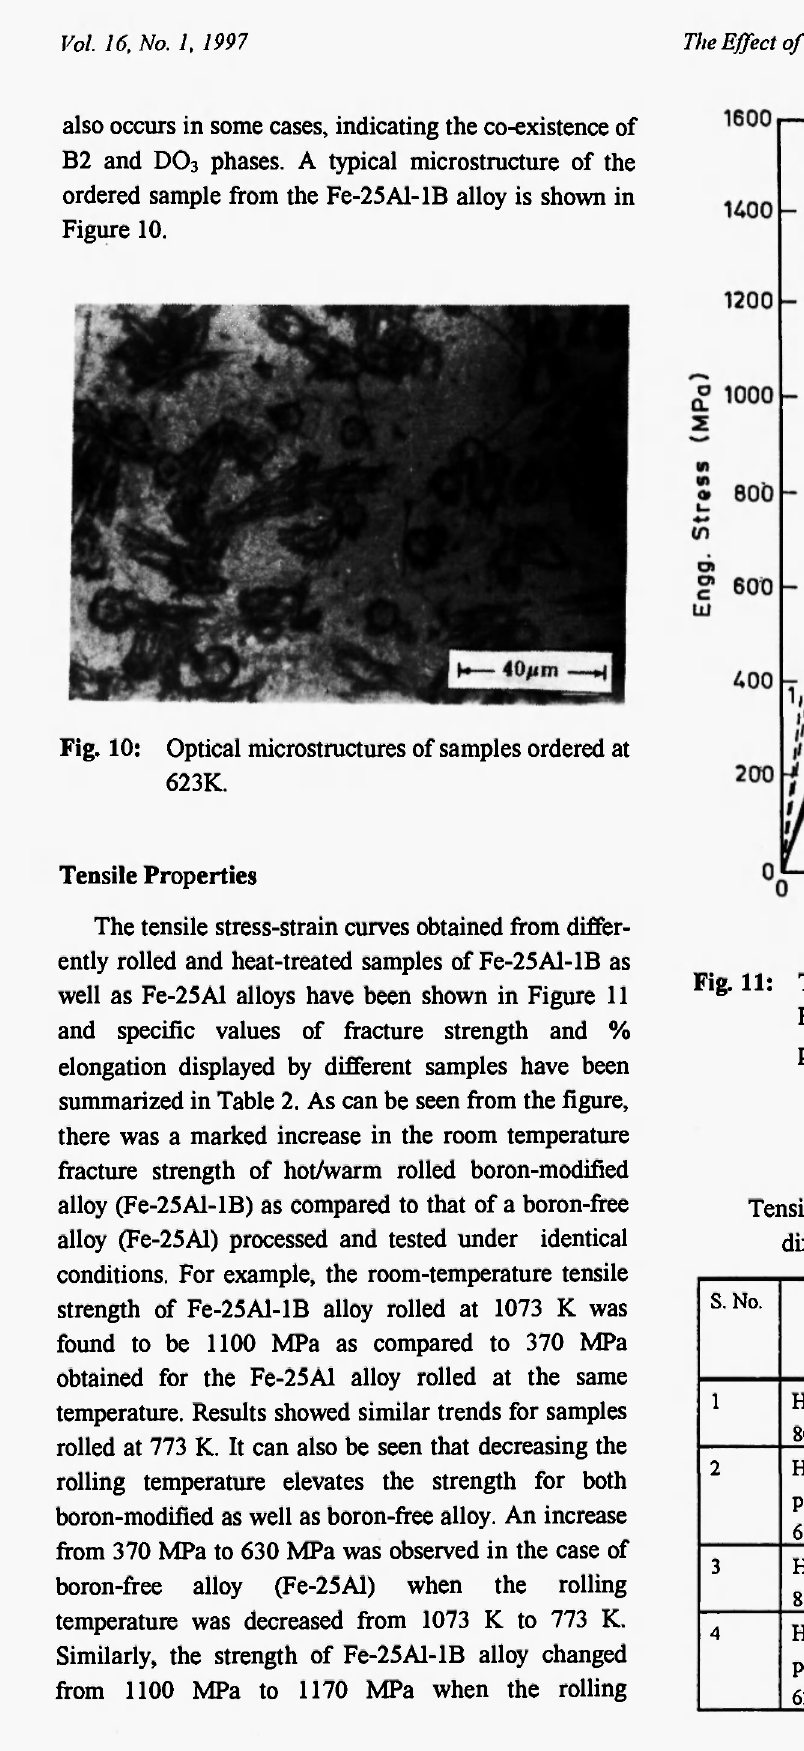
Tensile fracture strength and % elongation of differently processed Fe-25A1-1B